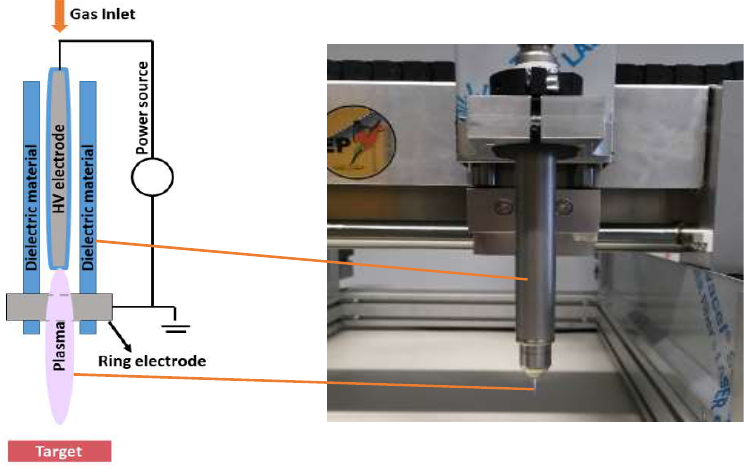
Figure 5. Schematic representation and picture of the kINPen ® IND used in the experiments.